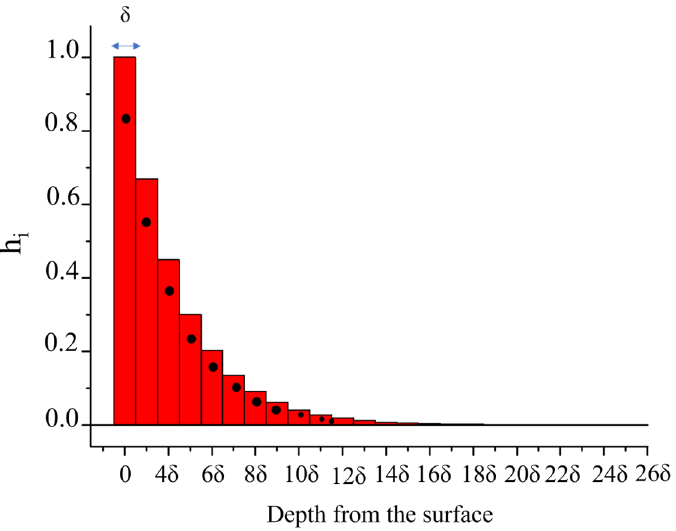
Figure 3. The column plot of the e − y / δ sd vs. depth curve, assuming δ sd = 100 nm: the black points show h i , the mean value of the ordinates corresponding to two successive layers of width 40 nm.